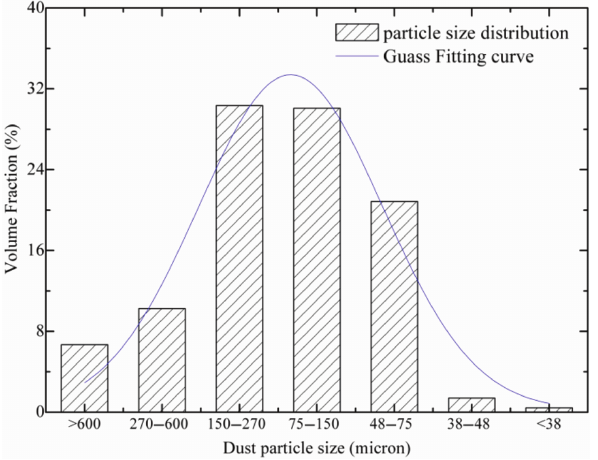
Figure 2: SSD particle size distribution in